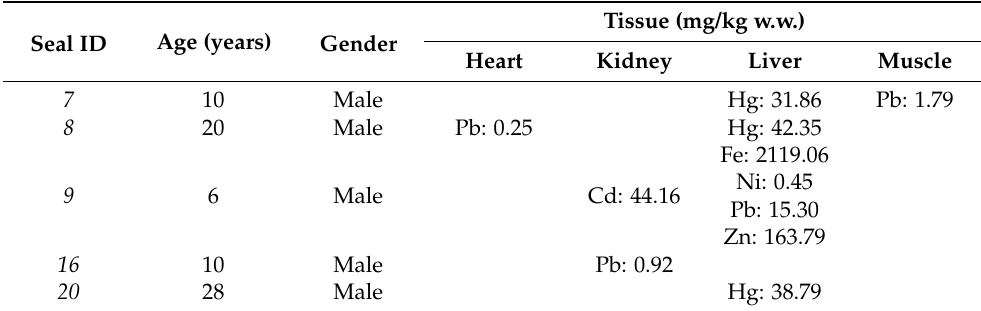
Table 5. Concentrations of trace elements as mg/kg w.w. in outlier Caspian seals. Data are reported by individual and by